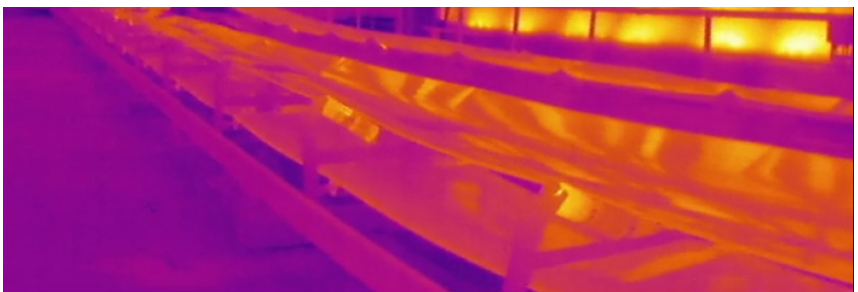
Figure 21. Exemplary frame with problem solvable by